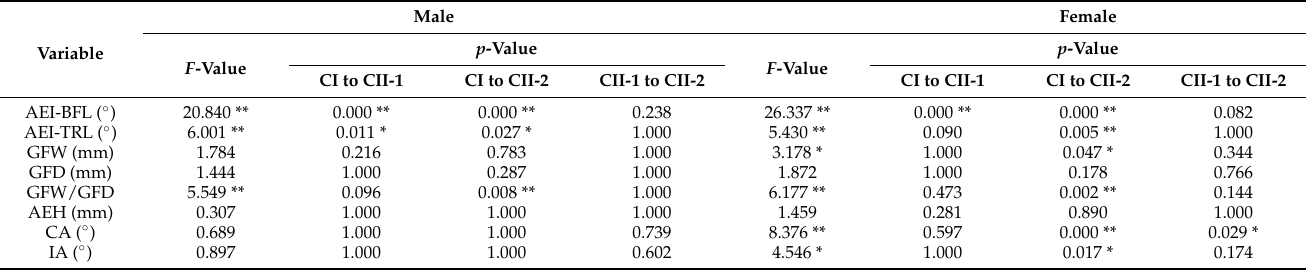
Table 6. Statistical summary of the measurements of the temporomandibular joint according to malocclusion in differ- ent